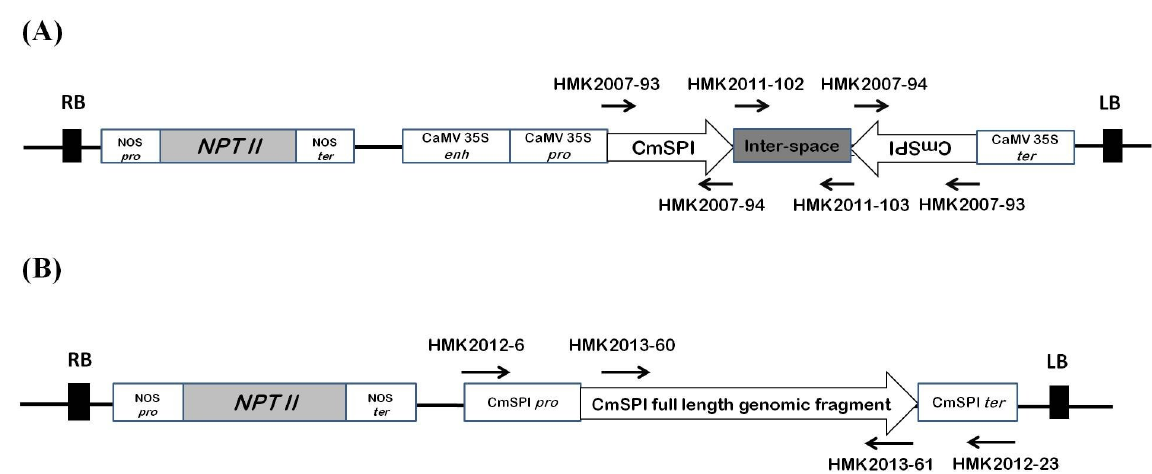
Figure 3. Constructs used for C. metuliferus and N. benthamiana transformation. ( A ) Construct for C. metuliferus CmSPI RNAi transformation. Partial sequence of CmSPI (203bp; from +46 to +692 nucleotide without intron sequences) was constructed into an invert-repeat form; ( B ) The construct for the transformation of full length genomic CmSPI into N. benthamiana plants. Arrows indicate the location of the primers used in the construction.